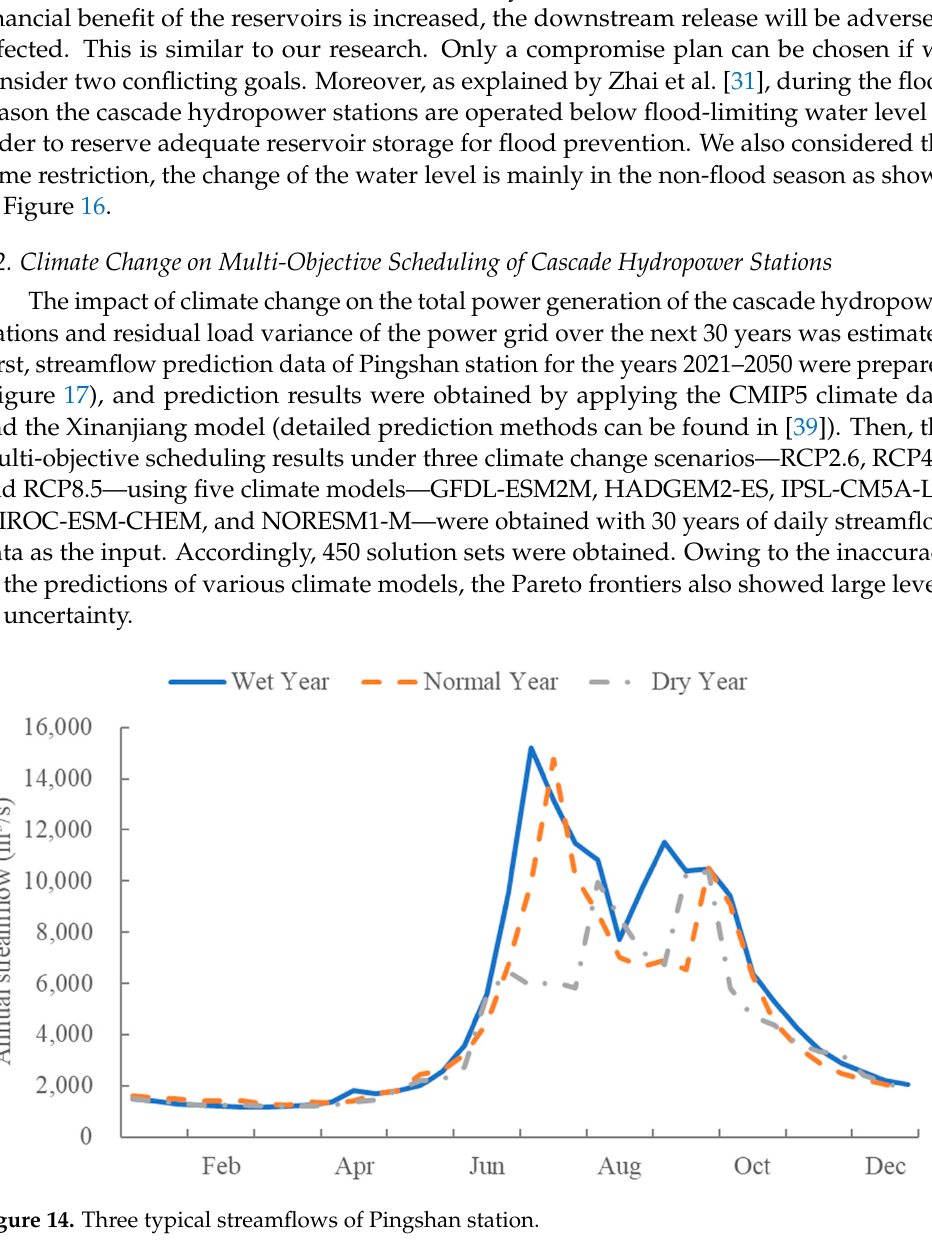
Figure 14. Three typical streamflows of Pingshan station.